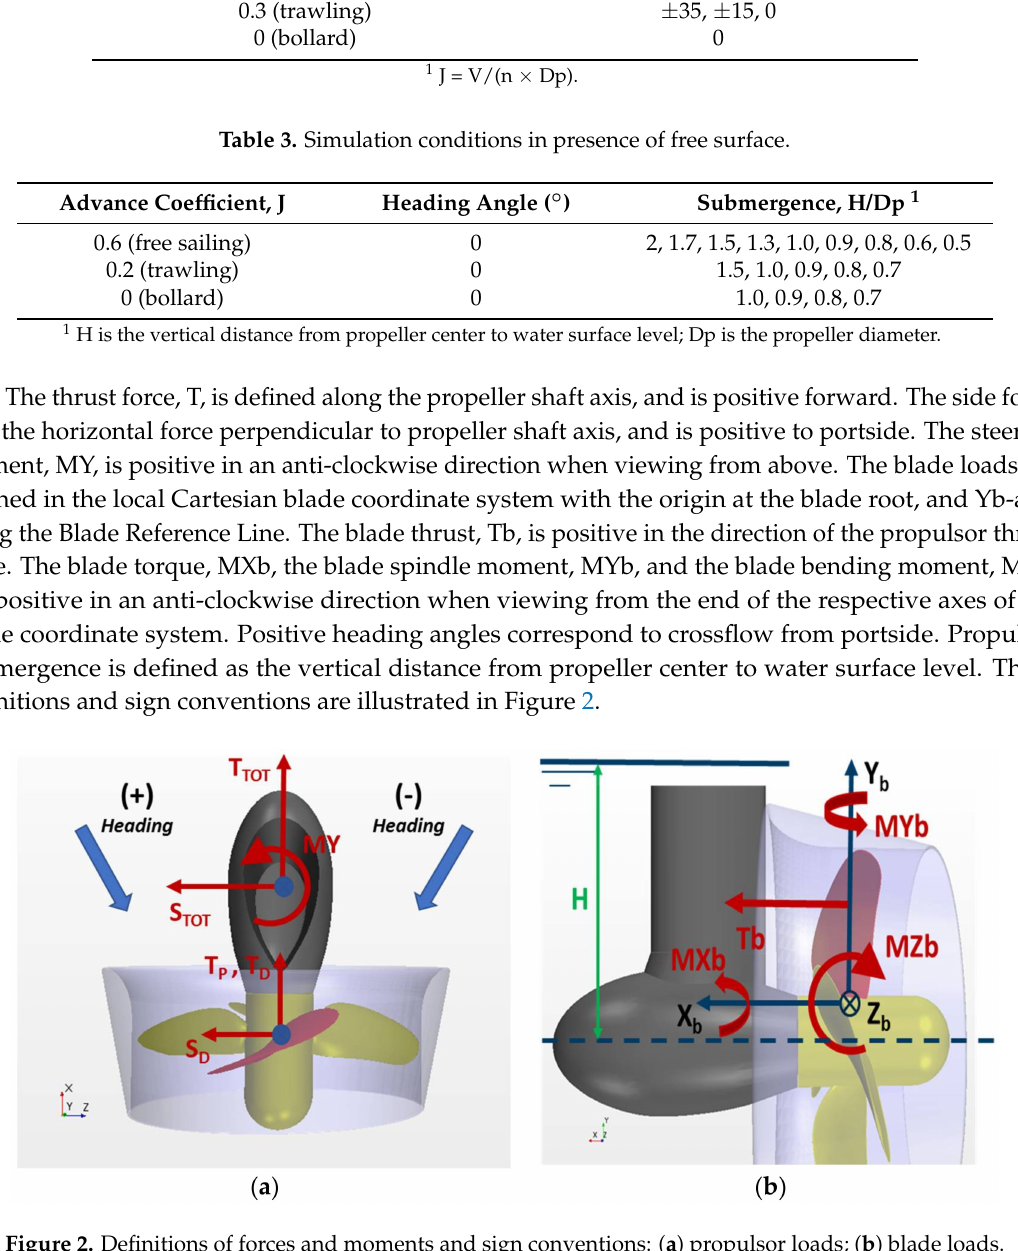
Figure 2. Definitions of forces and moments and sign conventions: ( a ) propulsor loads; ( b ) blade